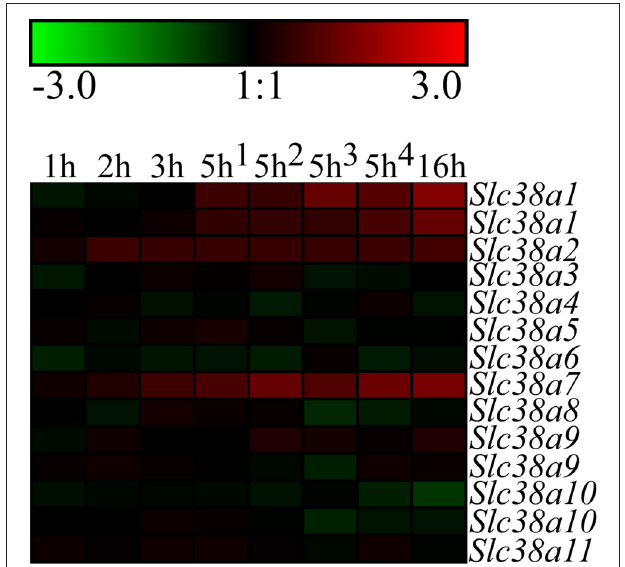
FIGURE 1 | Heat map analysis of the gene expression changes for Slc38a1-11 after complete amino acid starvation performed on the immortalized hypothalamic cell line N25/2. A heat map of the gene expression changes measured with microarray between starved cells and controls at 1, 2, 3, 5, or 16h. The color scale represents the log2 difference between starved and control cells. Green color represents downregulation and red color represent upregulation of gene expression. Note that Slc38a1 , Slc38a9, and Slc3810 had two probes each on the gene chip and the expression scores from both probes are presented in the heat